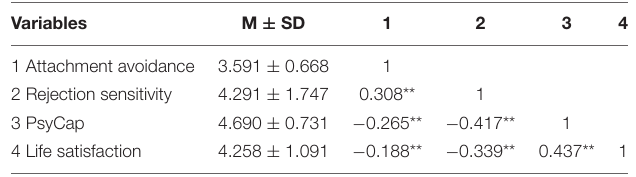
TABLE 1 | Means, standard deviations, and